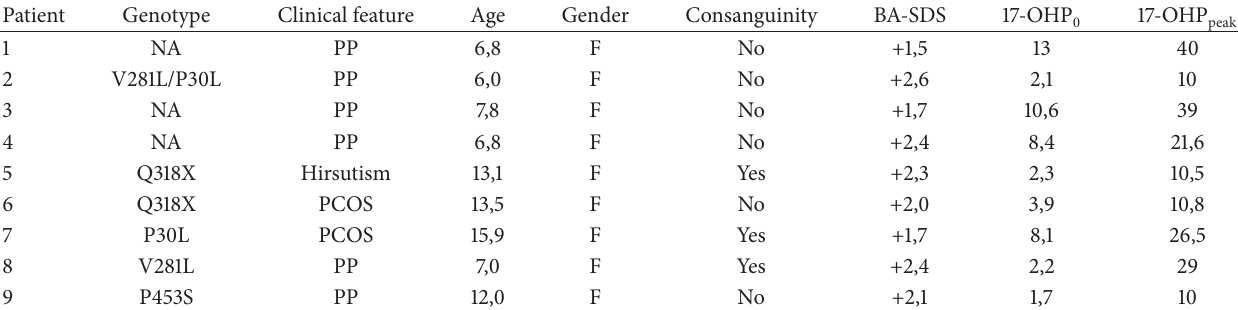
Table 3: Clinical characteristics and genotypes of patients with nonclassic congenital adrenal